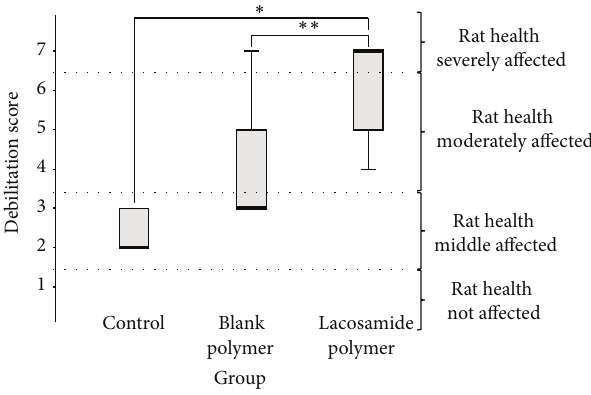
Figure 3: Postoperative debilitation scores obtained for groups control ( 𝑛 = 6 ), blank polymer ( 𝑛 = 6 ), and lacosamide polymer ( 𝑛 = 6 ). Rats from the lacosamide polymer group had debilitation scores that were higher when compared to the 2 other groups ( ∗ 𝑝 = 0.002 ; ∗∗ 𝑝 = 0.041 ). The box indicates the interquartile range (25th to 75th percentile), and the whiskers indicate the